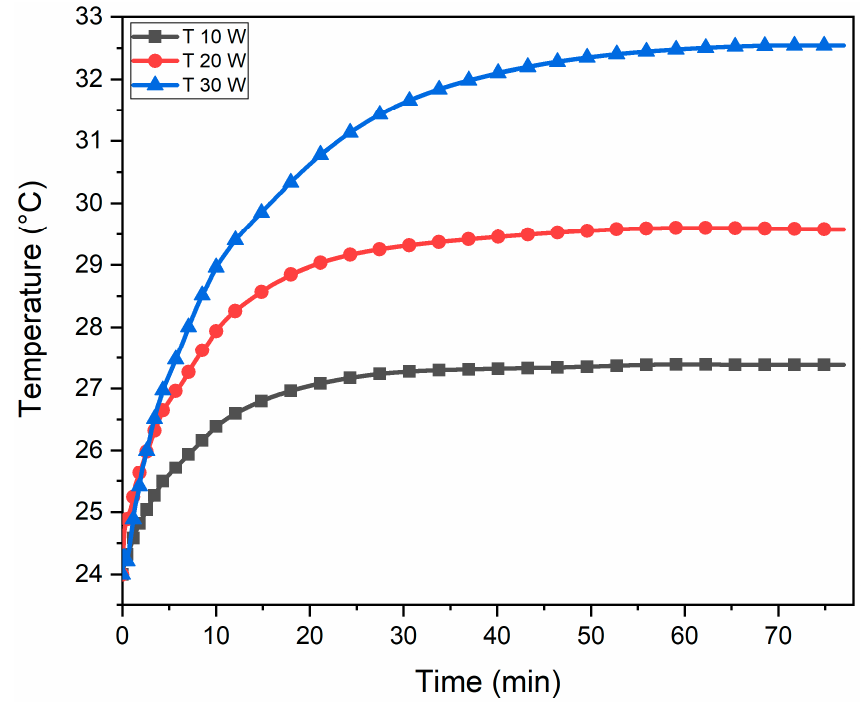
Figure 19. Effect of varying power level on crossflow configuration.